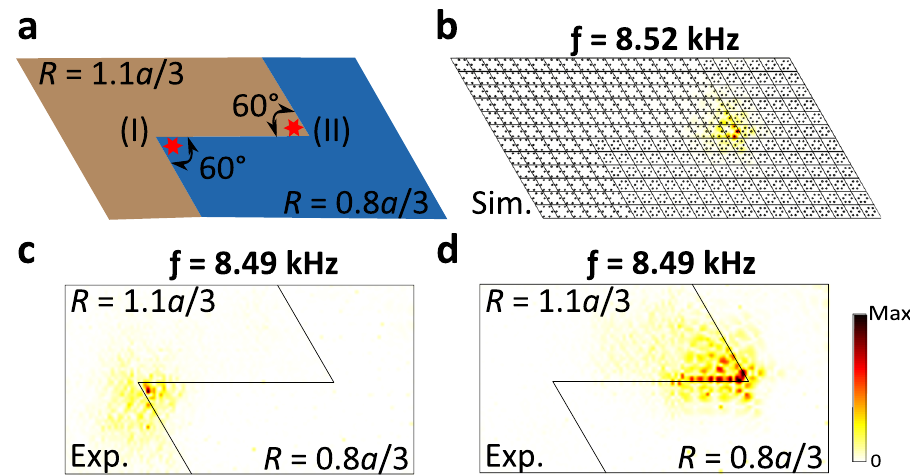
Fig. 4 Experimental veri fi cation of the corner state at 60 ∘ corners. a A Z-shaped interface with two different 60 ∘ corners is created via placing trivial cells ( R = 0.8 a /3) with non-trivial cells ( R = 1.1 a /3) adjacently. The red stars mark the locations of the piezo-actuators that excite the elastic plate. b A simulated eigenmode shows that corner state appear only at the corner (II) at f = 8.52 kHz. c , d Experimentally-extracted wave fi eld in the bolted plate when the piezo-actuator is attached on the corner (I) and corner (II), respectively, and excited at f = 8.49 kHz.